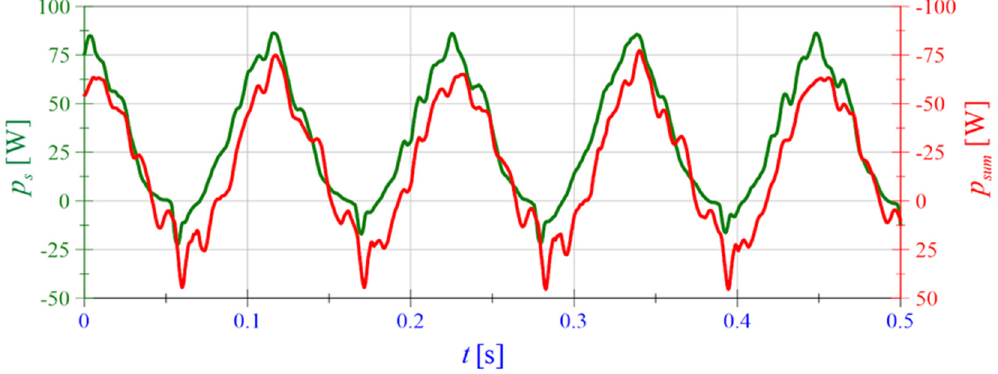
Figure 11. Time histories of power p s and p sum .